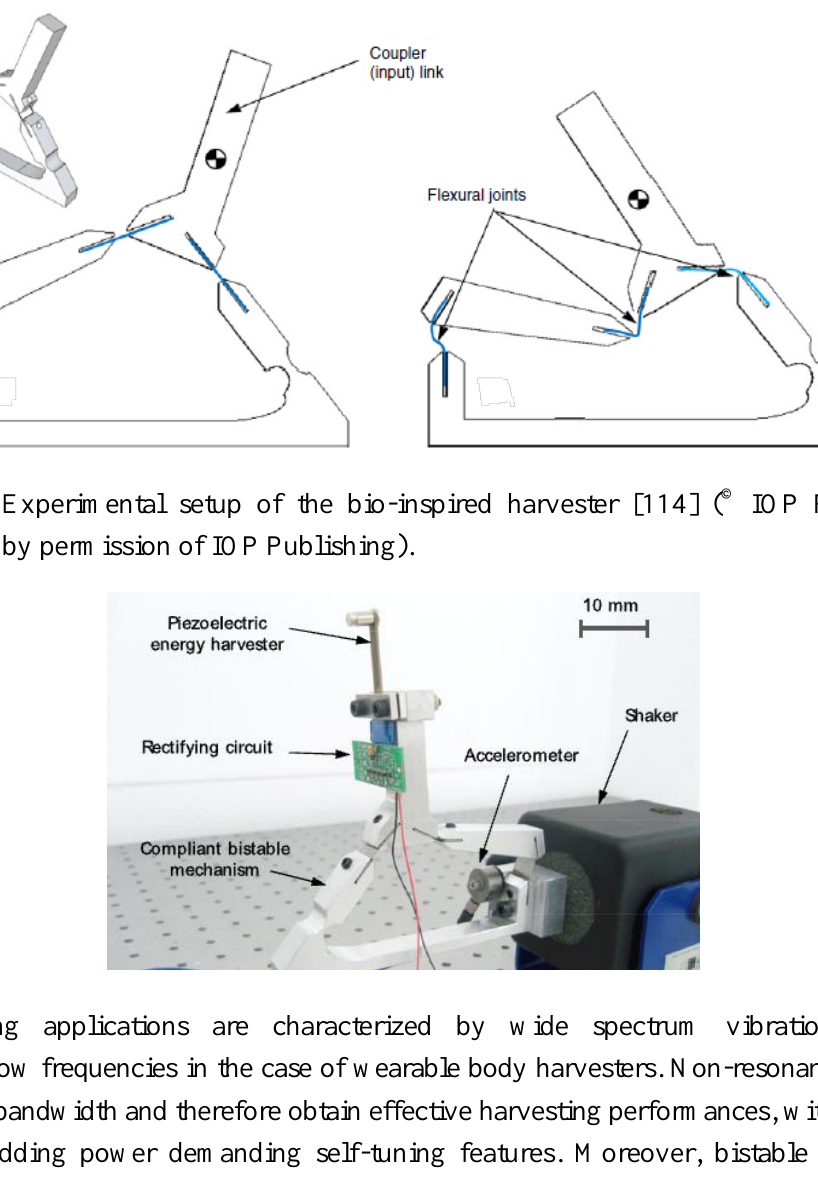
Figure 26. Bio-inspired bi-stable structure [114] ( © IOP Publishing. Reproduced by permission of IOP Publishing).